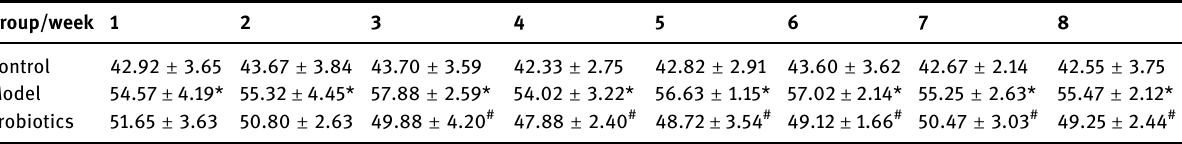
Table 2: E ff ects of Probio - M8 strains on food intake ( g/day ) of T2D mice Group/week